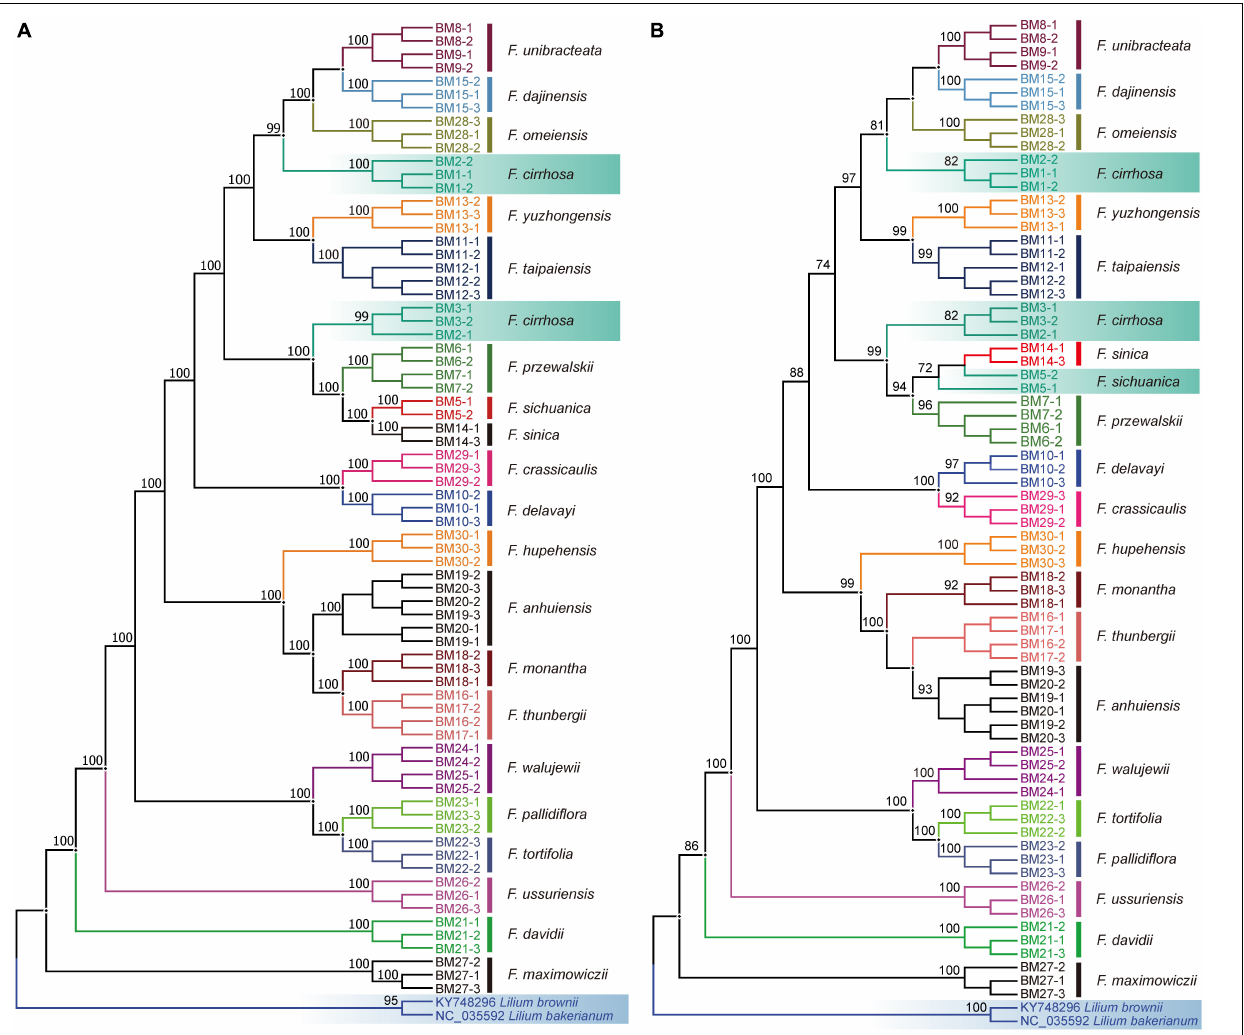
FIGURE 3 | The NJ trees of the 73 Fritillaria samples based on the complete plastome (A) and ycf1 (B) . Incorrect discrimination and outgroups are highlighted with the gradient colors. Bootstrap values are shown on the